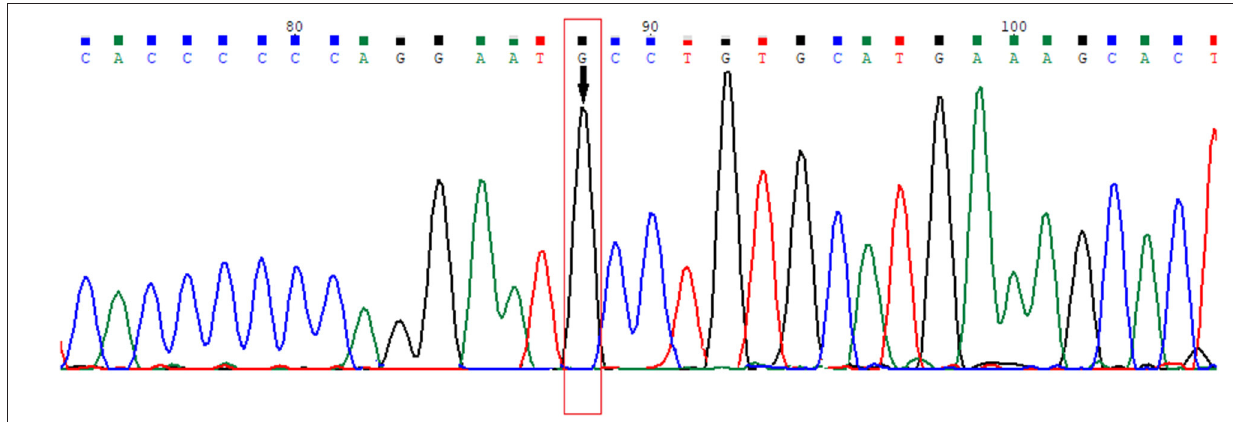
FIGURE 3 | Electropherogram of the novel variation in the 6th exon of the AR gene (HGVS nomenclature: NC_000023.11:g.67721928T > G, NG_009014.2:g.182897T > G, NM_000044.3:c.2414T > G, NP_000035.2:p.Phe805Cys).